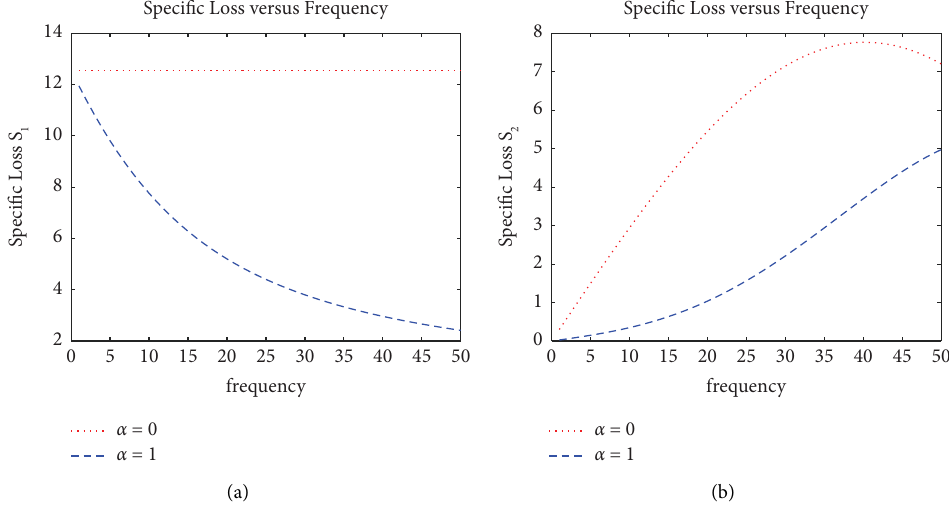
Figure 3: Specifc loss w.r.t. frequency ω .